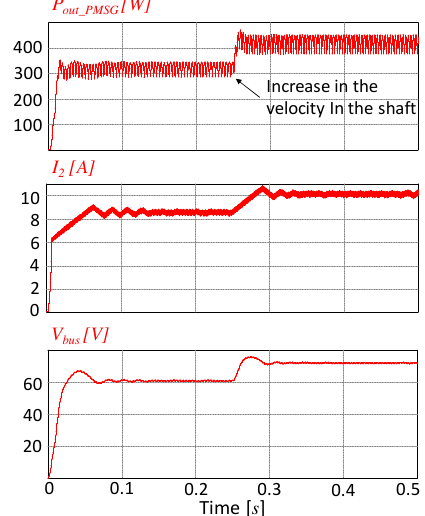
Figure 16. MPPT achieved in the PMSG by keeping the voltage in the capacitor C bus constant.